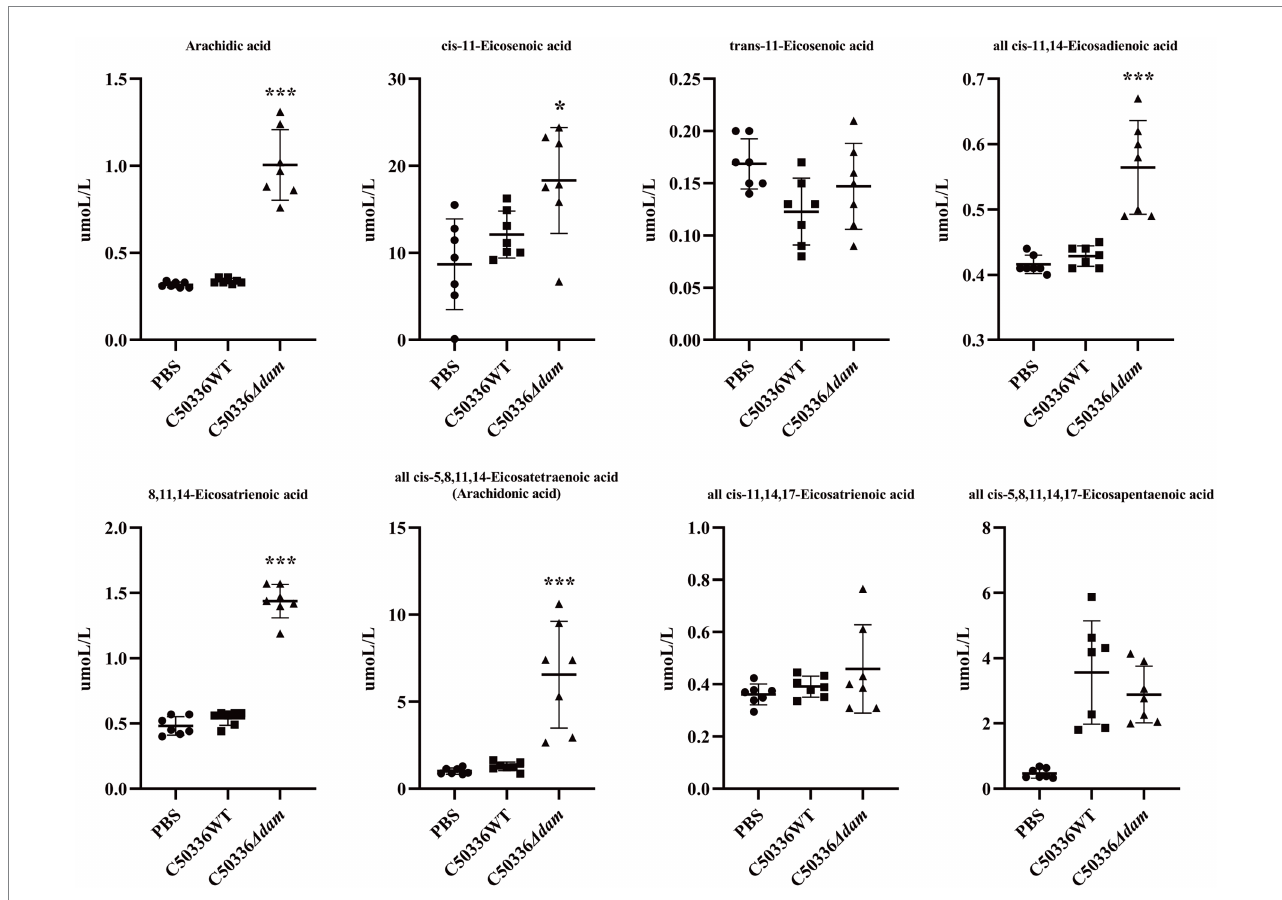
FIGURE 4 Fatty acid-targeted metabolomics results for eicosanoids. The circle in the figure is the PBS treatment group, the square is the C50336WT treatment group, and the triangle is the C50336 Δ dam treatment group, and each Figure is the quantitative analysis result of a single sample. *** p < 0.001, * p < 0.05 for one- way ANOVA followed by Bonferroni’s multiple comparison test. ALL data were presented as mean ± SEM ( n =